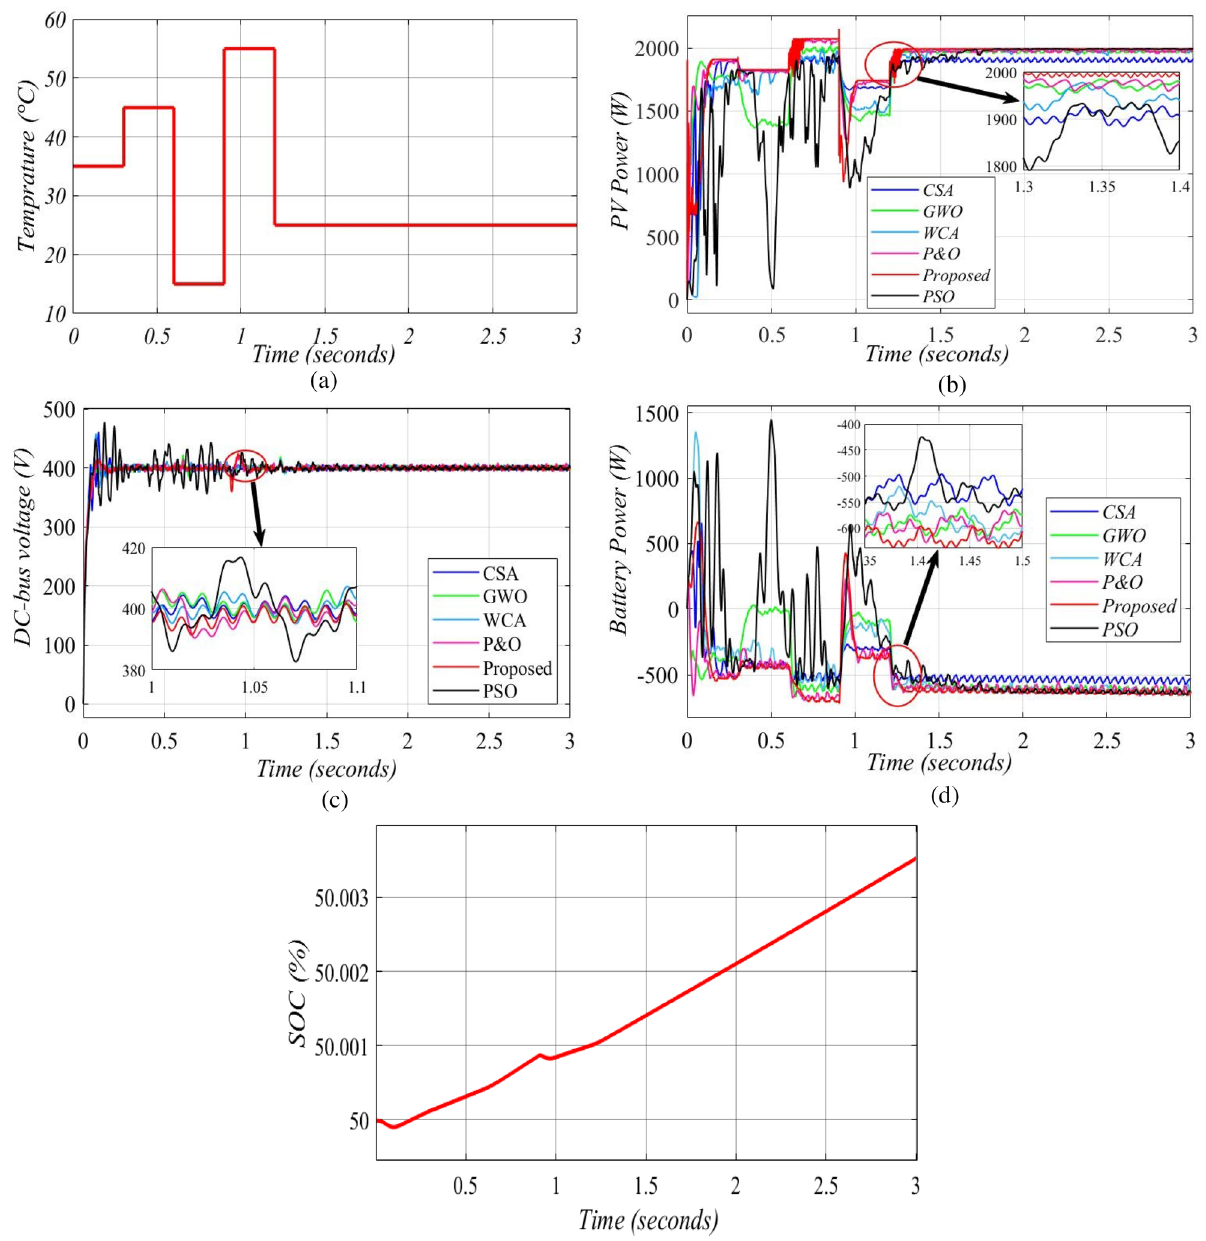
Figure 14. Simulation output of temperature changes in case 2: ( a ) temperature scenarios; ( b ) PV system output power; ( c ) DC-bus voltage output; ( d ) battery output power; ( e ) the SOC % of the